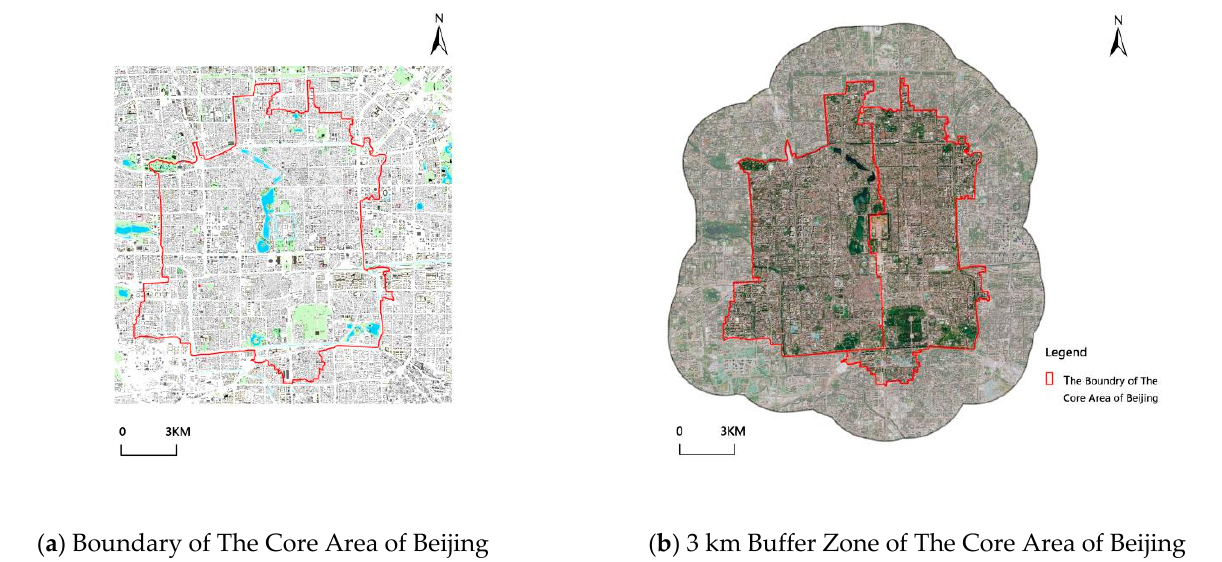
Figure 1. The Mapping of the Core Area of Beijing ( a ) defines the boundary of the core area of Bei- jing; ( b ) defines the boundary of the 3 km buffer zone of the core area of Beijing. ( b ) defines the boundary of the 3 km buffer zone of the core area of